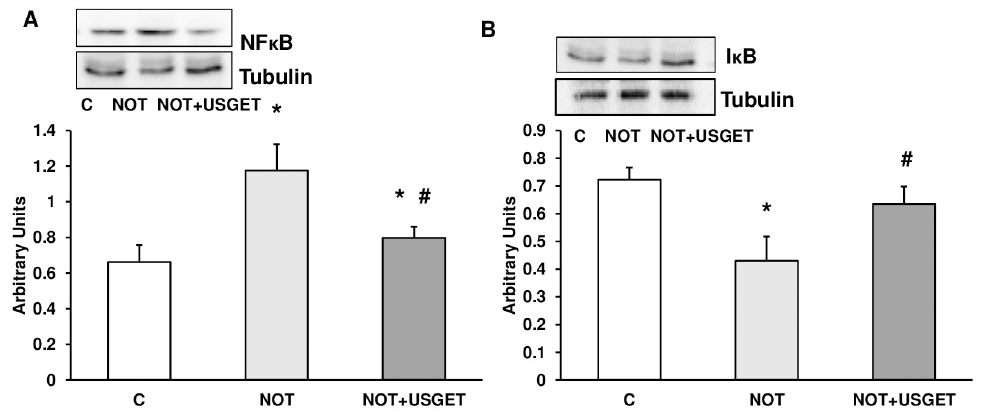
Fig 6. Rat muscle without notexin (C) or with notexin (NOT) or notexin with USGTE (6 mA) (NOT+USGTE) was collected to determine A: NF ᴋ B and B: I ᴋ B by Western-blot. NF ᴋ B, I ᴋ B and tubulin cropped from different parts of the different gels. Data are means ± SD from five independent experiments. � p < 0.05 vs. control. #p < 0.05 vs. notexin.